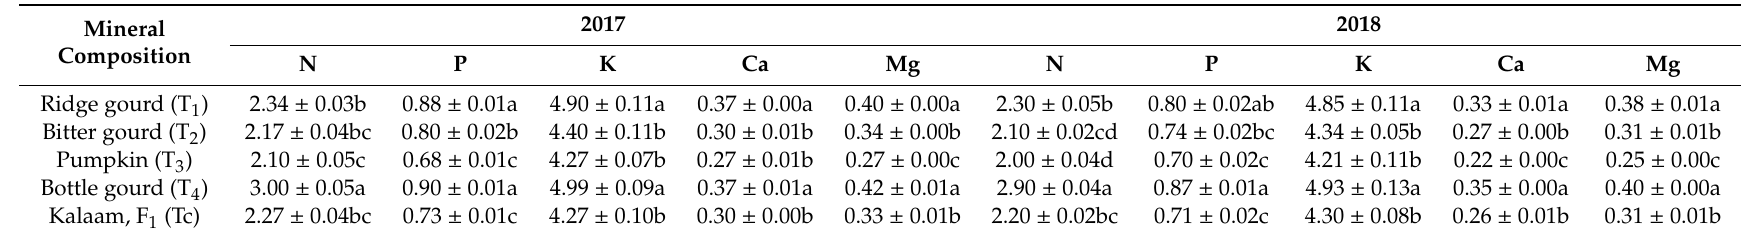
Table 6. E ff ect of Scion / rootstocks combinations on mineral contents in cucumber